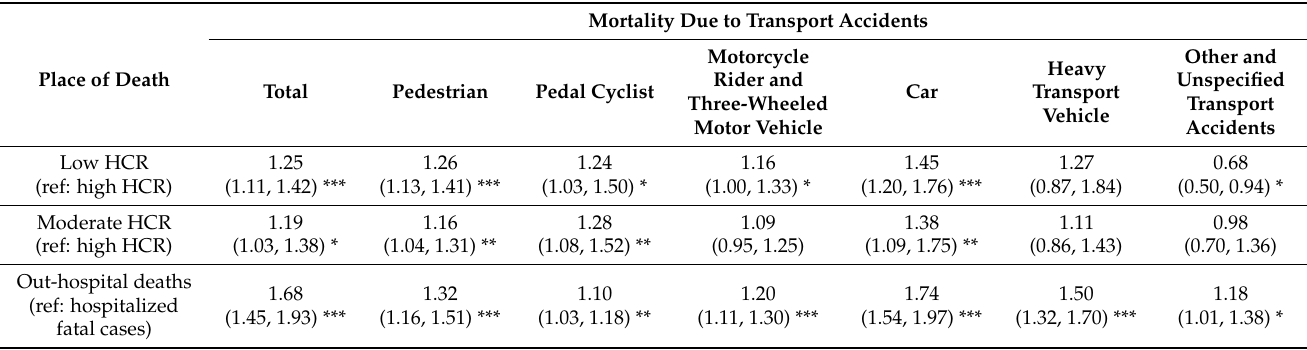
Table 4. Incidence rate ratio (IRR) for deaths due to transport accidents by health care resources (HCR) (reference category: moderate HCR) and for out-of-hospital deaths (reference hospital deaths) and by type of accident. Place of Death Total Pedestrian Pedal Cyclist